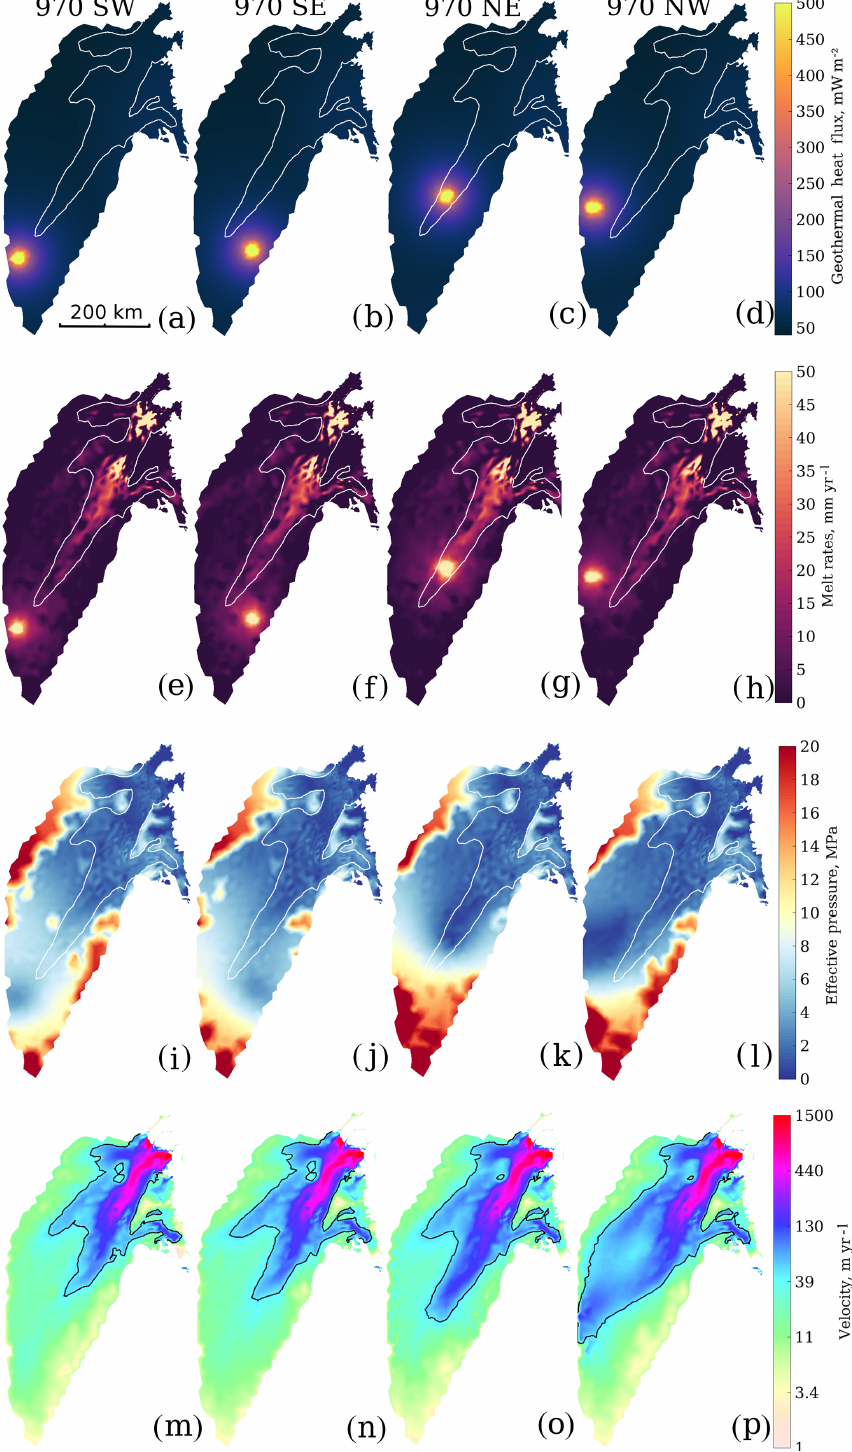
Figure 3. Model results from the sensitivity simulations investigating the position of the mantle plume by moving the plume970 75km. The first column shows results from plume970SW, with a plume 75km to the southwest; the second column represents the 970 SE plume; the third column represents plume970NE; and the last column is plume970NW. Panels (a–d) show the GHF, (e–h) the resulting basal melt rates, (i–l) the computed effective pressure and (m–p) the modelled surface velocity. White lines show the 50myr − 1 observed velocity contour, and black lines show the 50myr − 1 modelled velocity